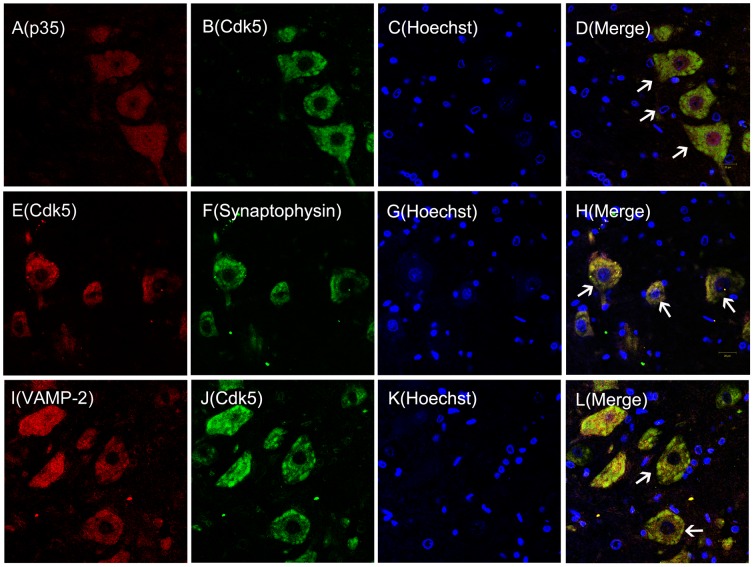
Cdk5 colocalizes with p35, synaptophysin, and VAMP-2.Double-immunofluorescence staining for p35 (red), Cdk5 (green or red), Hochest [a cell nuclear marker (blue)], synaptophysin (green) and VAMP2 (red) in ipsilateral spinal cord L4/L5 neuron sections of naïve rats (A–D). p35 colocalizes with Cdk5 (D, white arrow head).Cdk5 colocalizes with synaptophysin (H, white arrow head) (E–H). VAMP-2 colocalizes with Cdk5 (L, white arrow head) (I–L). (n = 3, per group, magnification X40, Bar = 20 µm).